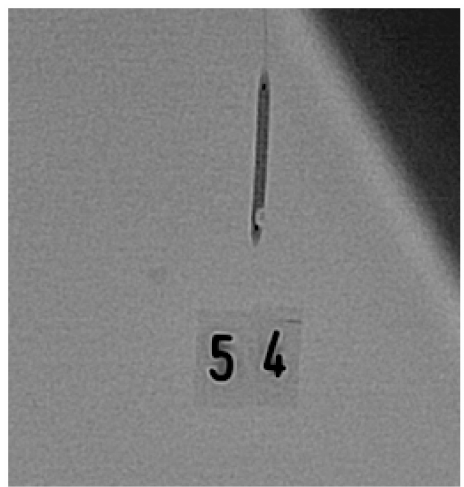
Figure 3. Balloon containing air.